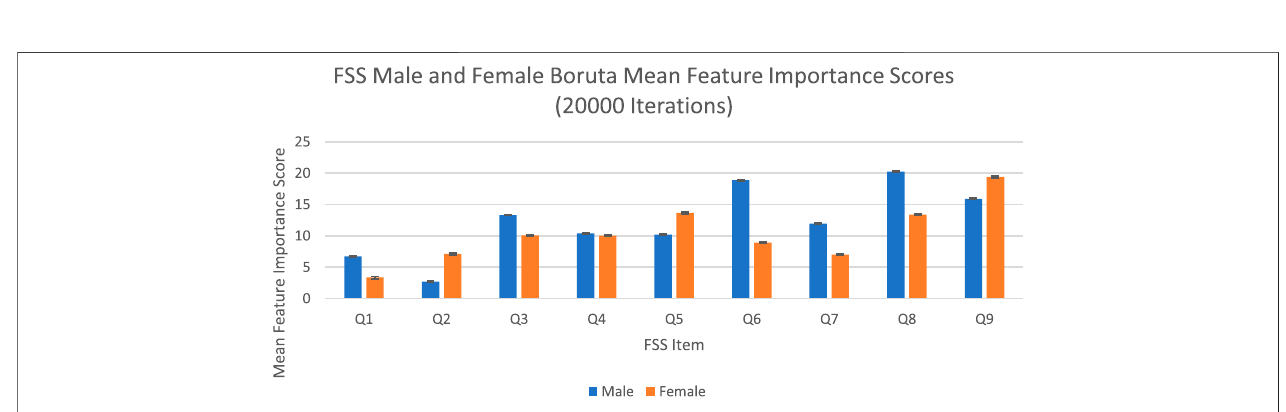
FIGURE 4 | FSS male and female Boruta mean feature importance scores for 20,000 iterations. Error bars represent 1 SD.